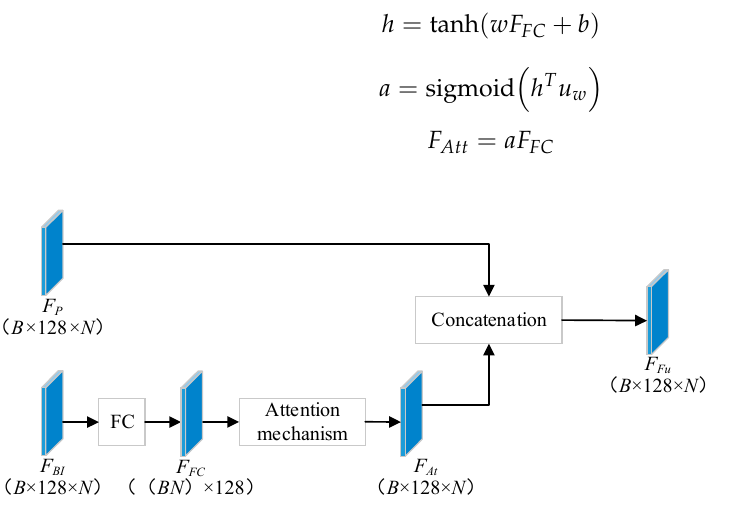
Figure 3. Architecture of the fusion network.